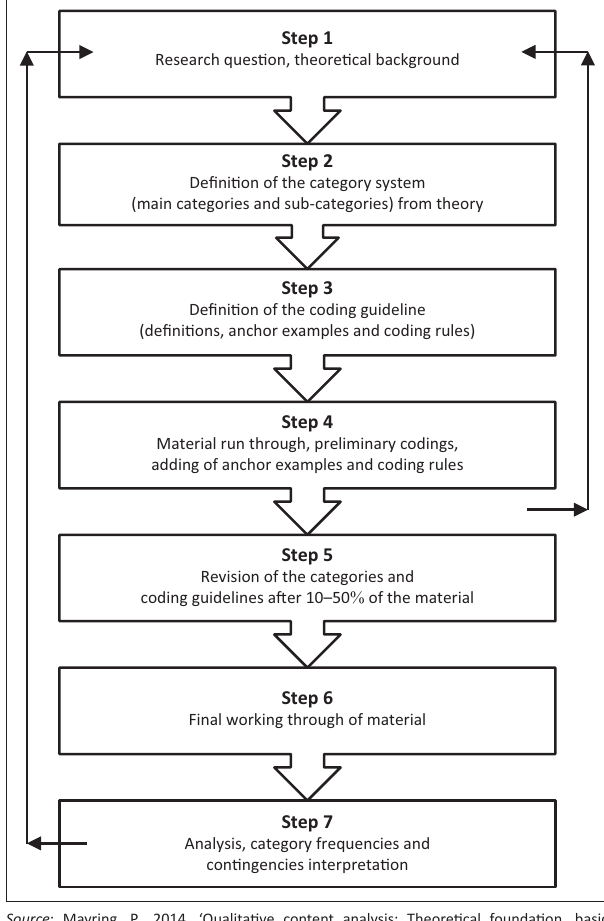
FIGURE 2: Procedural model of research methodology